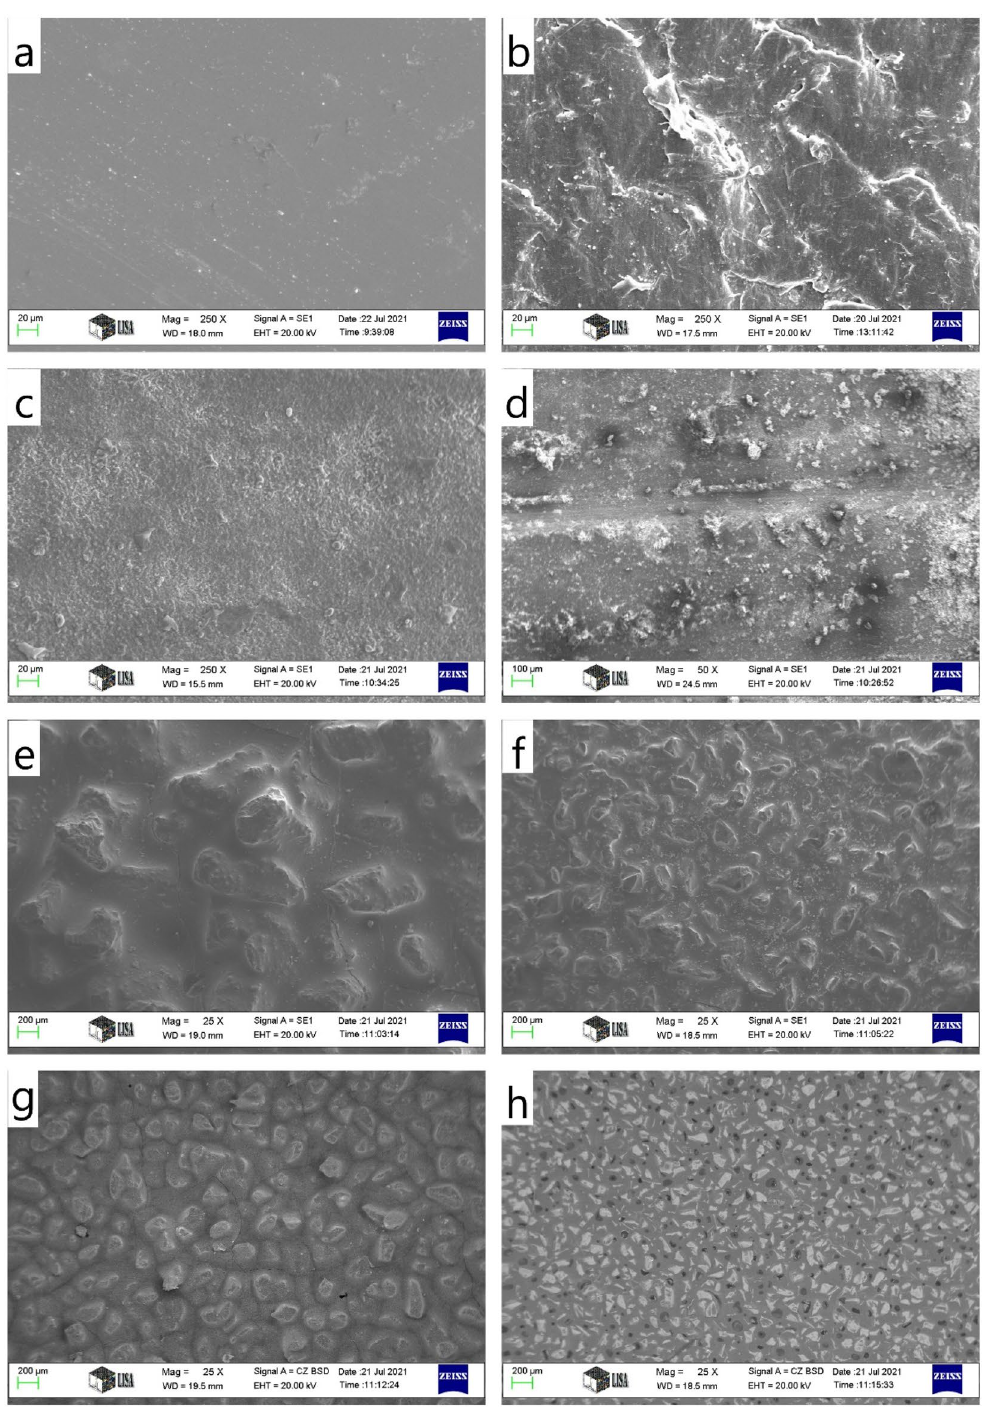
Figure 4. The surface of the used crucible materials, scanning electron microscopy (SEM) secondary electron (S.E.) images ( a ): glass, ( b ): TEFLON, ( c ): fine ALOX, ( d ): rough ALOX, ( e ): P40, ( f ): P80, ( g ): P120, and ( h ):